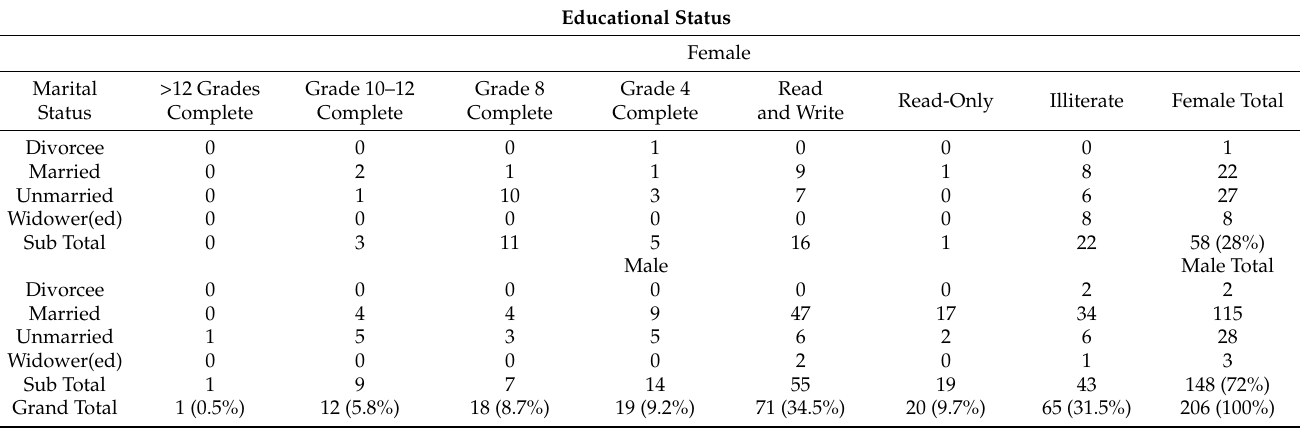
Table 2. Respondent’s Marital and Educational Status by Sex. Source: Authors’ Compilation from the household survey.